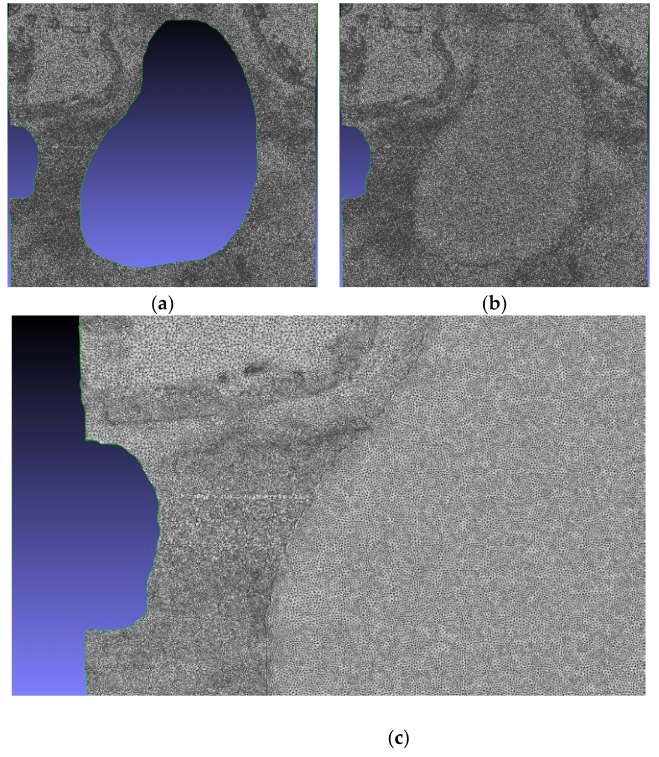
Figure 15. Hole filling results obtained via the Han algorithm: ( a ) open hole aggregation; ( b ) hole filling; ( c ) hole filling